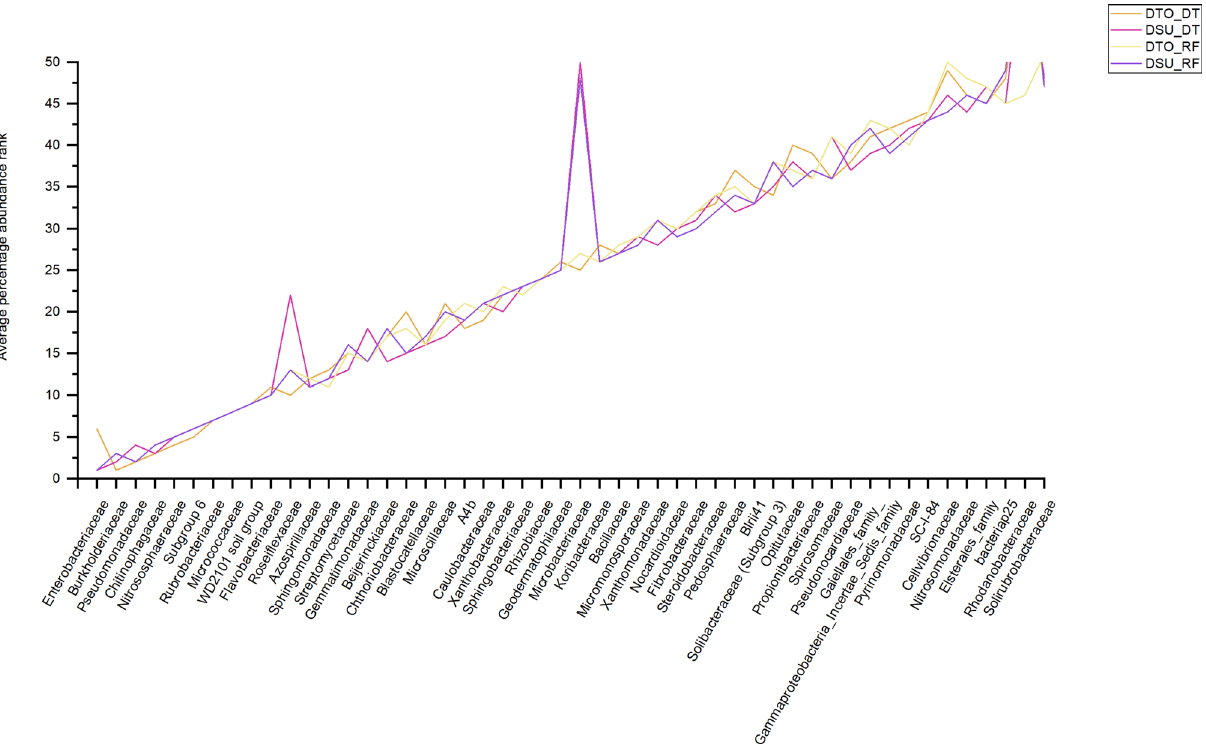
Figure 4. Comparison of the average percentage abundance of bacterial families between the two wheat lines (DTO and DSU), under the two environmental conditions (DT and RF). Families were sorted from highest to lowest based on percent abundance and ranked from highest value (Rank 1) to 50th value (Rank 50) for wheat line (DTO and DSU) and environmental condition (DT and RF). The minimum rank value was taken across the four lines/conditions, and the columns sorted from lowest rank to highest rank, with the rankings plotted as a line